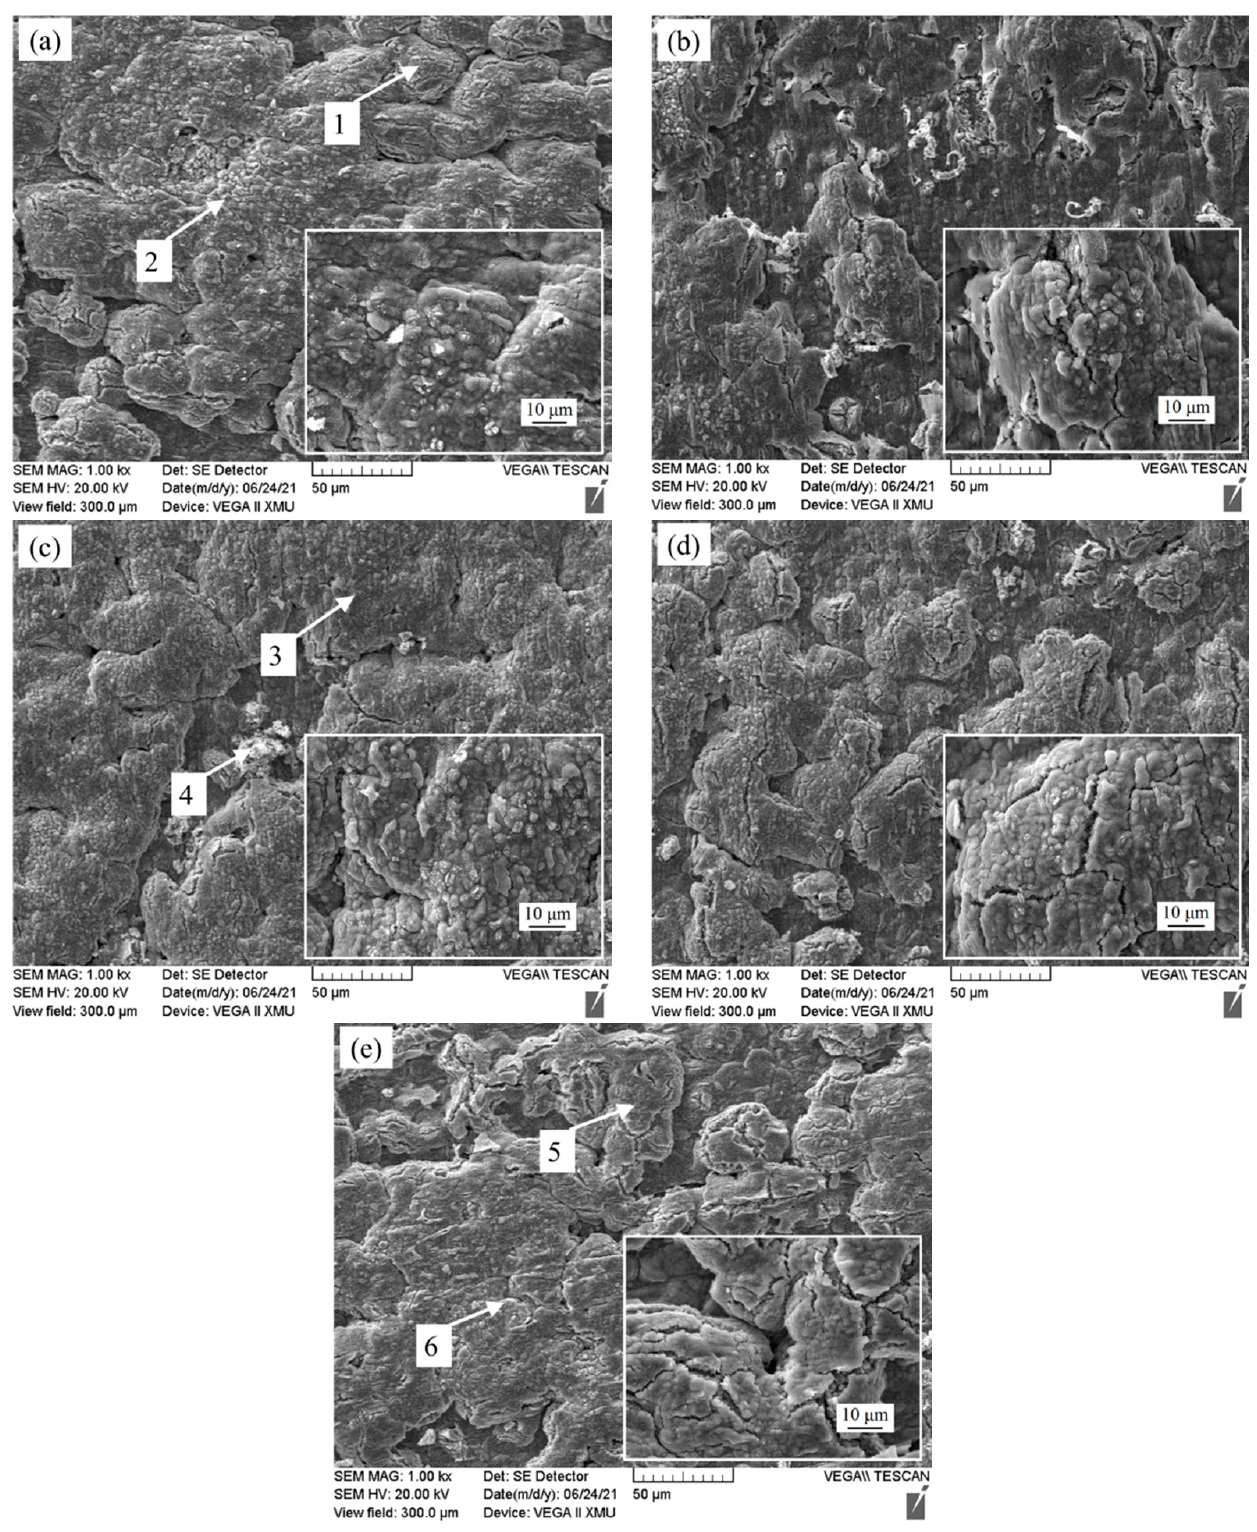
Figure 11. Surface morphology of Fe-25Mn-9Al-8Ni-1C-xTi alloy after 200h oxidation. ( a ) 0 wt.% Ti; ( b ) 0.1 wt.% Ti; ( c ) 0.2 wt.% Ti; ( d ) 0.3 wt.% Ti; ( e ) 0.4 wt.%